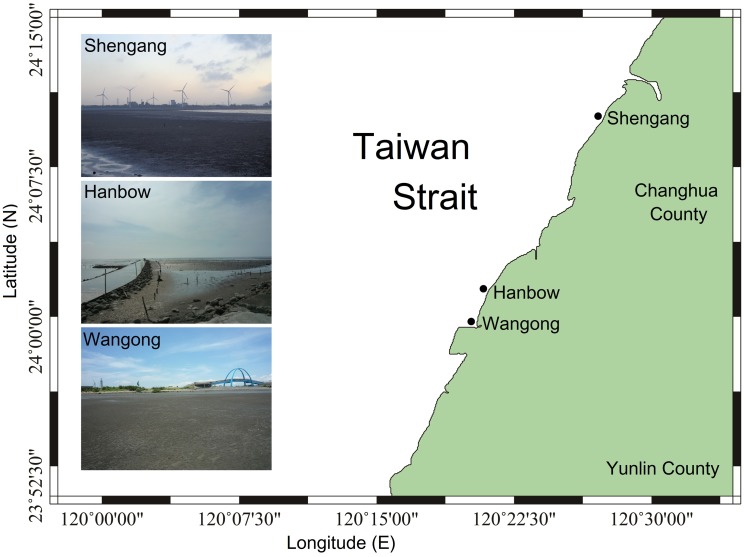
Map of the sampling area in western Taiwan.